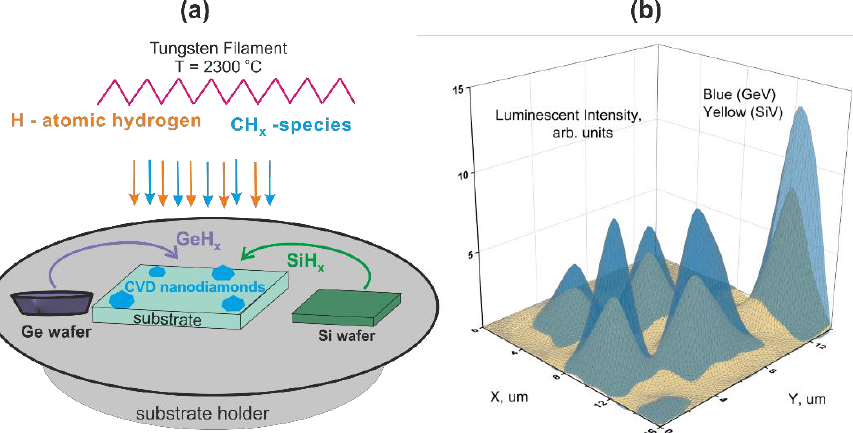
Figure 1. ( a ) A schematic diagram of growth and doping of diamond particles by Ge and Si atoms during hot filament chemical vapor deposition; ( b ) 2D ZPL intensity mapping of SiV − or GeV − centers at a methane concentration of